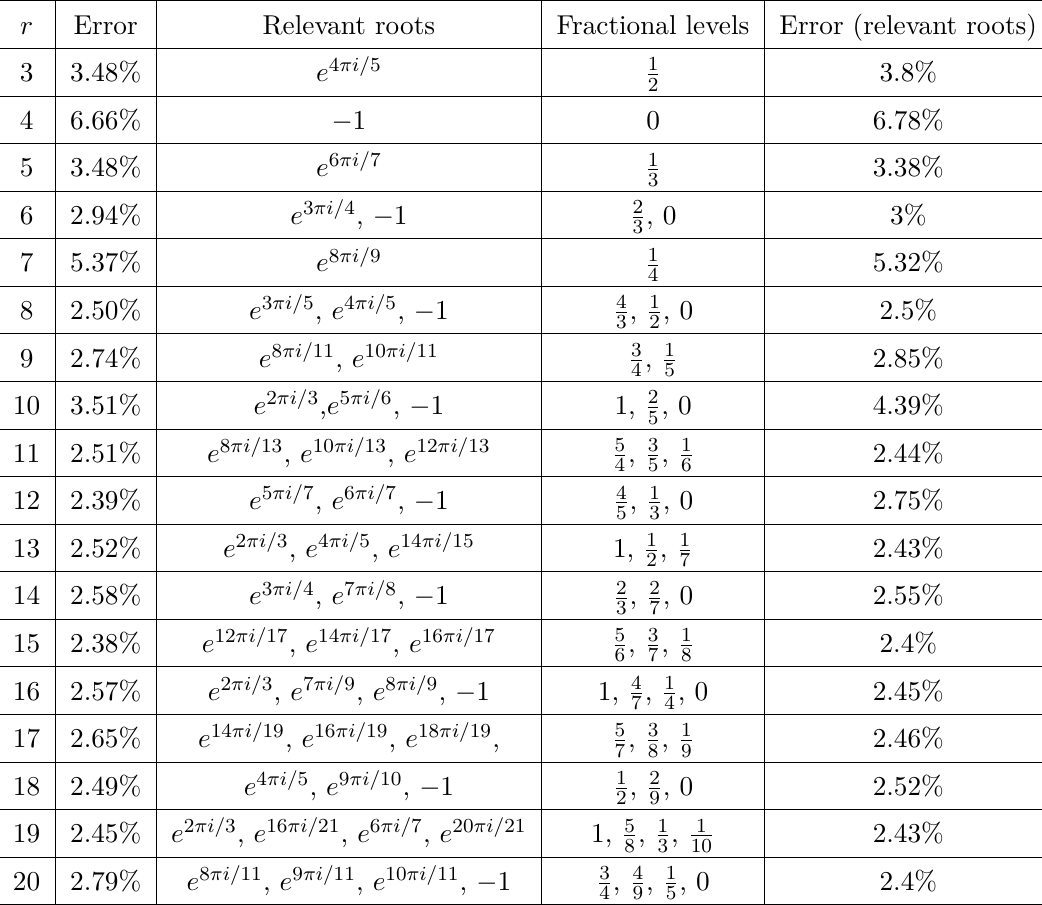
Table 1 . LRP results when training the neural network on different roots of unity, corresponding to different r . The third column shows the roots relevant to calculating the output, the fourth column shows the corresponding fractional levels k obtained by writing the relevant roots as e 2 πi/ ( k +2) , and the final column the error when training the network on only the relevant